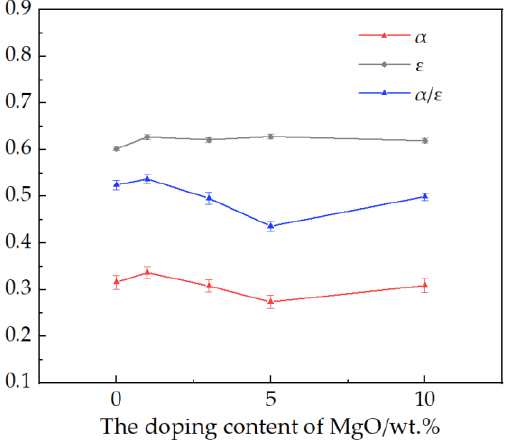
Figure 3. α / ε values of the Al 2 O 3 ceramic pellets with different MgO doping Figure 3. α/ε values of the Al 2 O 3 ceramic pellets with different MgO doping contents.